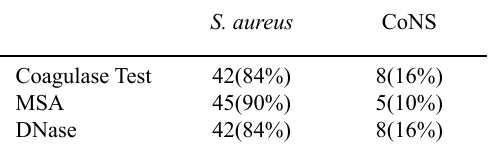
table 4. Detection of Nuc gene among